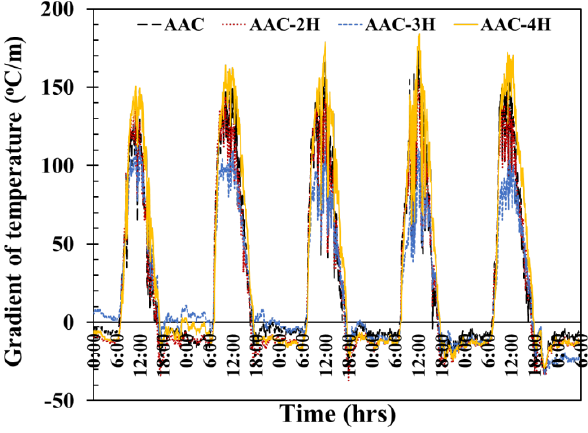
Figure 12. Evolution of gradient of temperature of the 4 testing rooms.